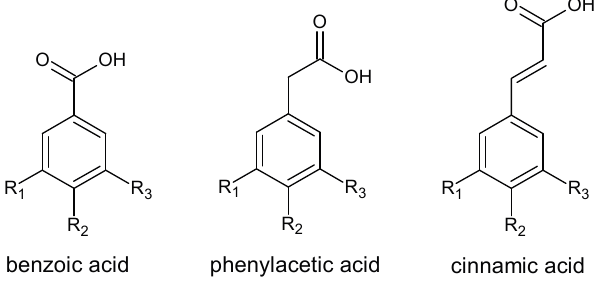
Figure 1. The basic structures of phenolic acids.